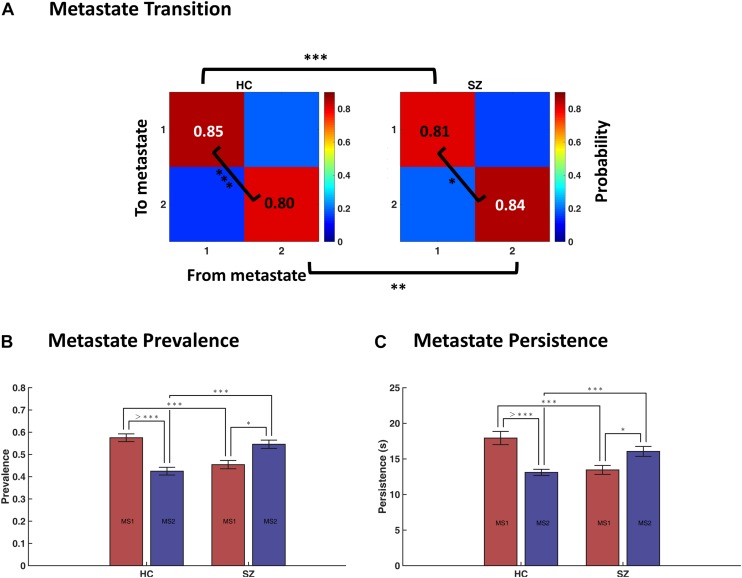
Temporal characteristics of metastates (MS). (A) Average transition probability matrices of metastates, for the healthy control (HC, left panel) and schizophrenic (SZ, right panel) subjects. Dwell probabilities (i.e., the diagonal entries) were compared within and between groups. (B) Difference in the prevalence (i.e., probability of occurrence) of MS1 and MS2, within and across groups. (C) Difference in the persistence (i.e., uninterrupted occupancy) of metastates, within and across groups. The key finding here is that MS1 is dominant in the HC, whereas MS2 prevails in SZ. Statistical tests were permutation-based t tests (paired, when appropriate). Error bars denote standard errors of mean (SEM). Asterisks denote significant difference in mean, after FDR correction (∗ indicates p < 0.05; ∗∗ indicates p < 0.01; ∗∗∗ indicates p < 0.001; > *⁣** indicates p < 0.0001).